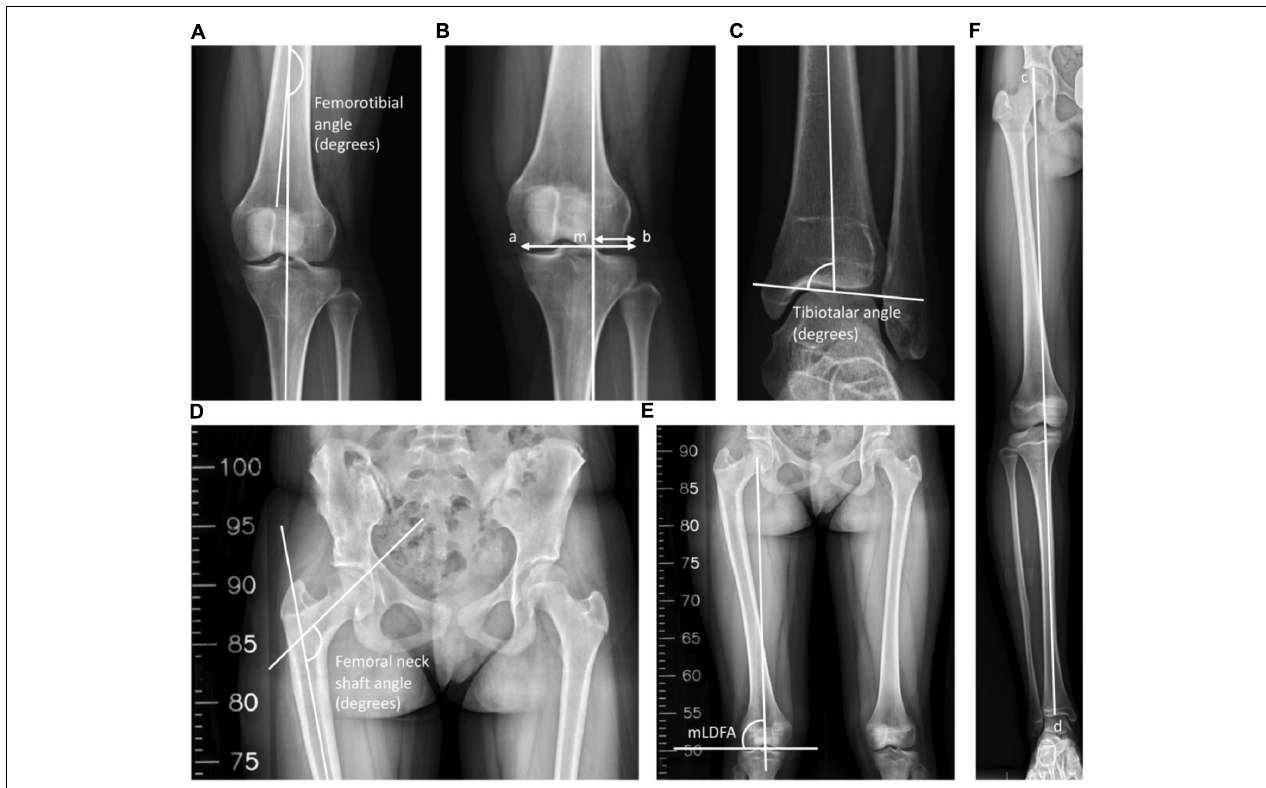
FIGURE 1 | Radiological measurements. (A) The inferolateral angle between the anatomical axis of the femur and the tibia was defined as the femorotibial angle (FTA). (B) The mechanical axis of the leg was a line drawn through the center of the femoral head and the center of the tibial plafond, and M was the point of intersection between the knee and the mechanical axis. The mechanical axis deviation (MAD) was defined as the ratio of the distance between the mechanical axis and the lateral-most part of the tibia plateau to the width of the tibial plateau. MAD = (mb/ab) × 100%. (C) The superomedial angle between the anatomical axis of the tibia and the upper surface of the talus was defined as the tibiotalar angle (TTA). (D) The inferomedial angle between the longitudinal axis of the neck and shaft of the femur was defined as the femoral neck-shaft angle (FNSA). (E) The lateral angle between the mechanical axis of the femur and the lower surface of the femoral condyle was defined as the mechanical lateral distal femoral angle (mLDFA). (F) The leg length was defined as the distance between the top of the femoral head and the midpoint of the tibial plafond. Leg length = cd.